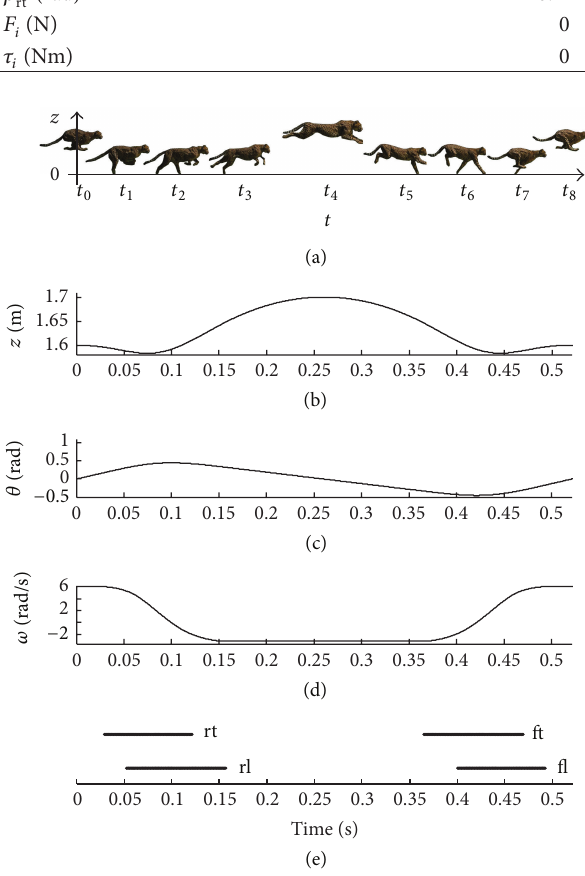
Figure 2: The galloping process of a